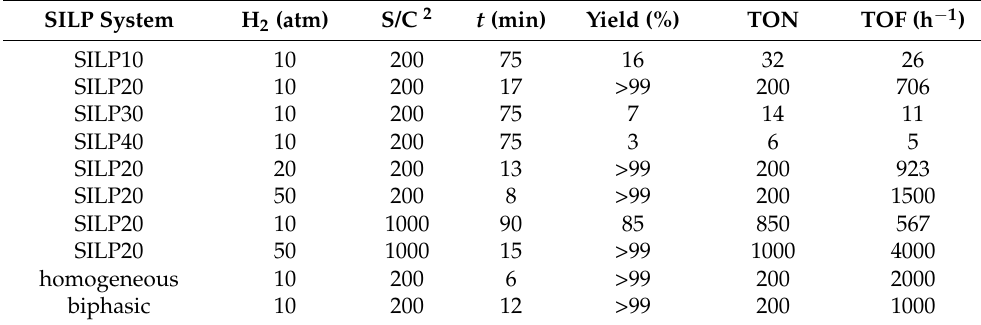
Results obtained by Kirchner and collaborators from the hydrogenation 1 of 4- fluorobenzaldehyde using different SILP catalytic systems